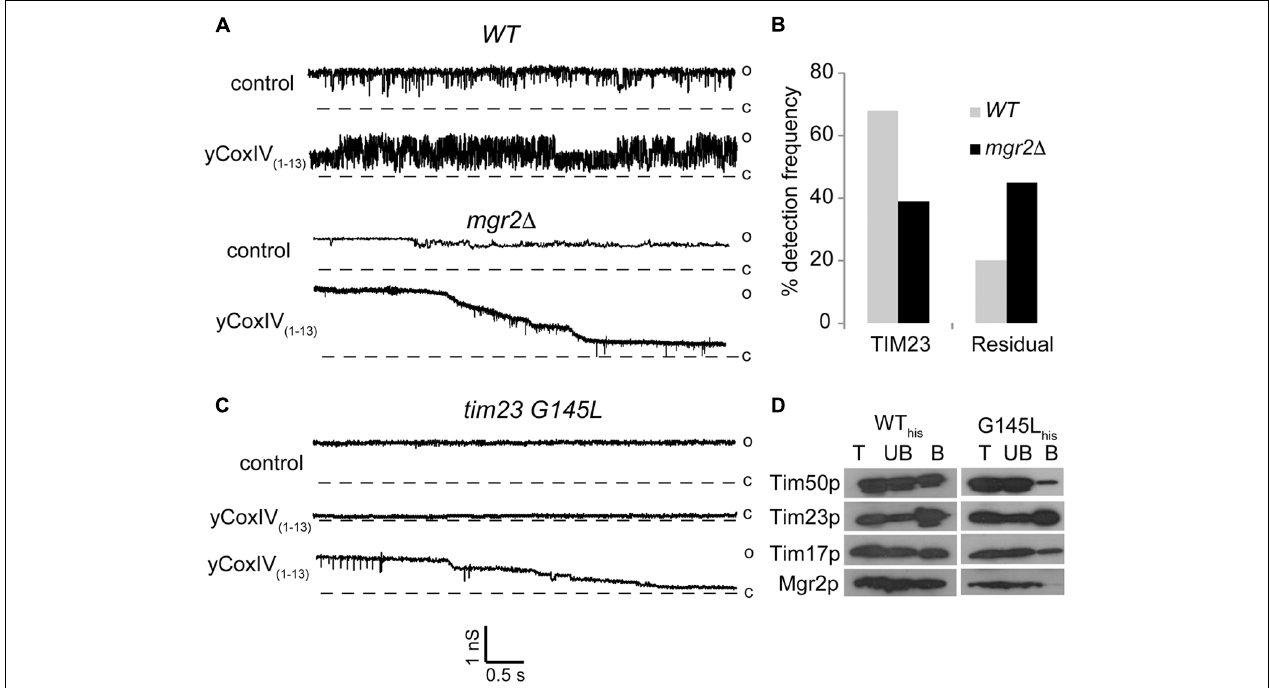
FIGURE 1 | Effect of Mgr2 deletion on the channel activity of TIM23. (A–C) Representative patch clamp current traces show TIM23 channel activity recorded from indicated mitochondrial inner membrane preparations before and after addition of 5 µ M presequence peptide yCoxIV ( 1 − 13 ) . The vertical and horizontal scale bars indicate conductance in nanosiemens and time in seconds, respectively. Open “o” and closed “c” states are indicated to the right of the current traces. (B) Bar histograms of normal and residual TIM23 channel frequencies in WT and mgr2 (cid:49) mitochondria. Data are average from n > 50 recordings per condition. (D) Immunoblotting following a pull-down assay shows the presence of the indicated TIM23 components in total (T), unbound (UB) and bound B fractions from mitochondria containing wild type (WT his ) or mutant (G145L his ) Tim23 protein.